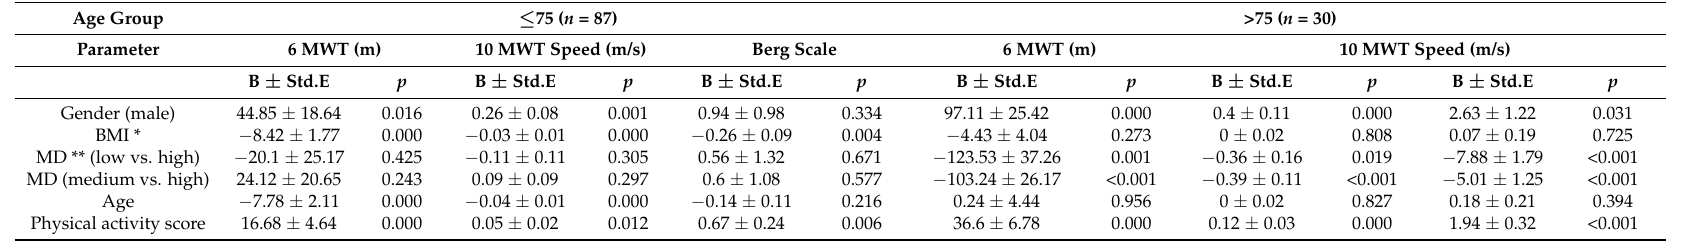
Table 3. GLM § models for 6 mw, 10 mwt, and Berg scale across age